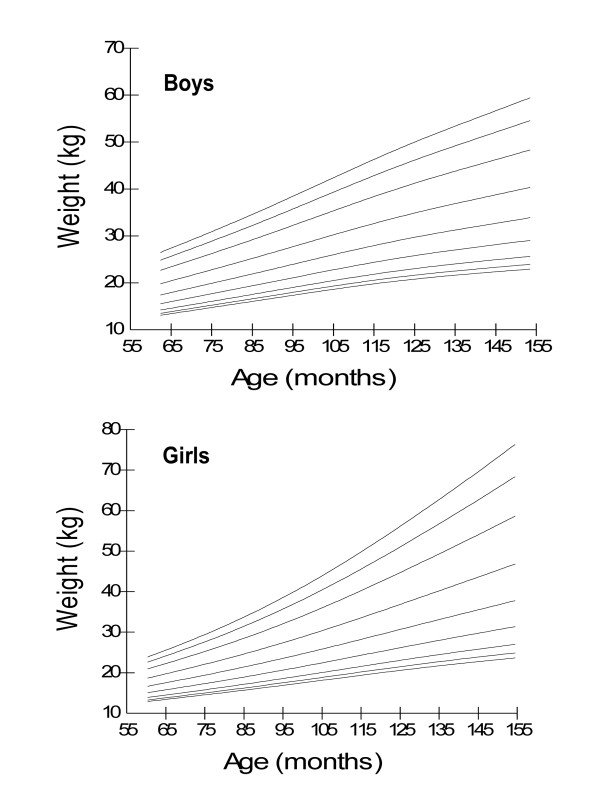
Smoothed weight percentile curves for Pakistani primary school boys (n = 997) and girls (n = 883) aged five to twelve years. 5 years (61-71 months), 6 years (72-83 months), 7 years (84-95 months), 8 years (96-107 months), 9 years (108-119 months), 10 years (120-131 months), 11 years (132-143 months) and 12 years (144-155 months).